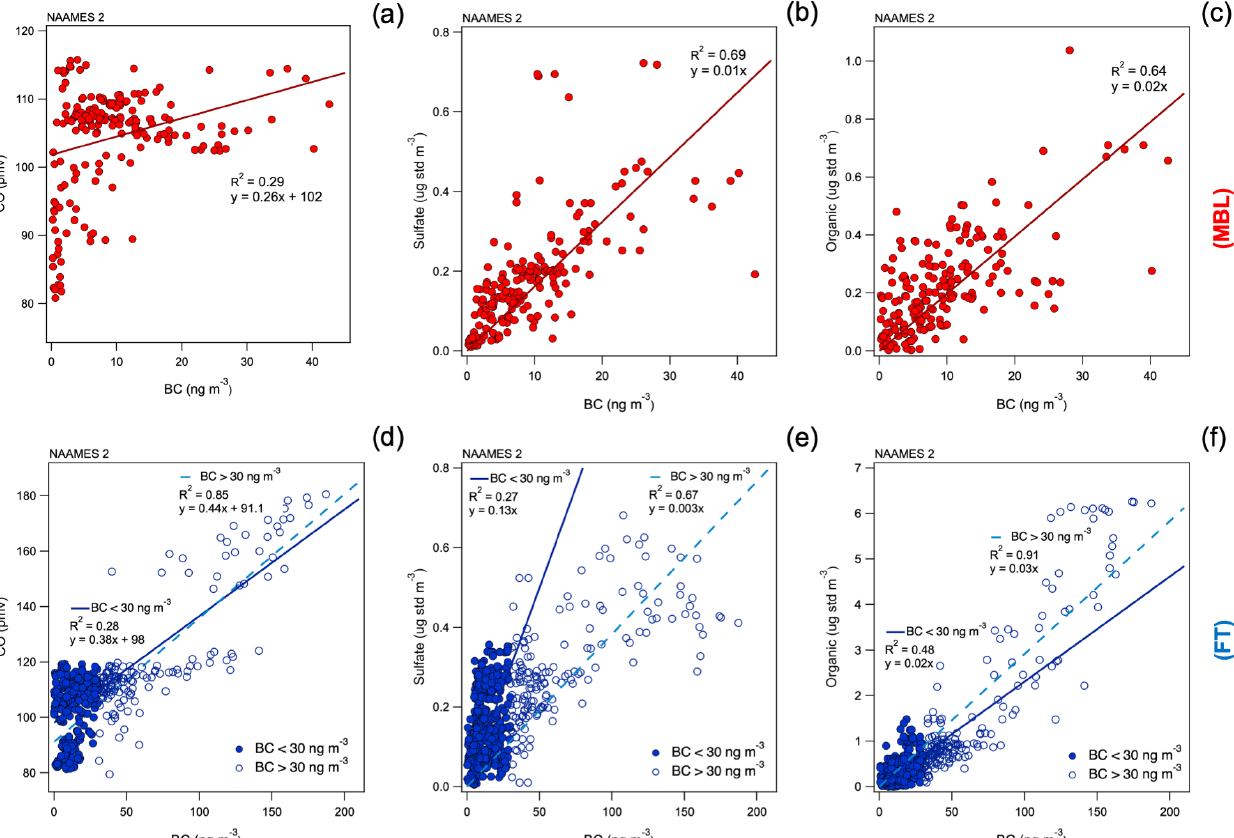
Figure 8. Correlation between BC and CO (a, d) , BC and sulfate (b, e) , and BC and organics (c, f) in the MBL (red) and FT (blue) during